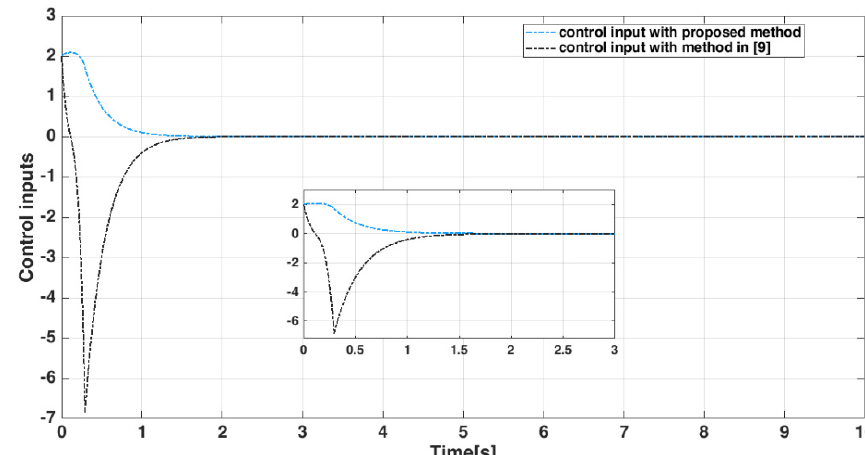
Figure 19. State error 𝒆 𝟔 of master-slave systems